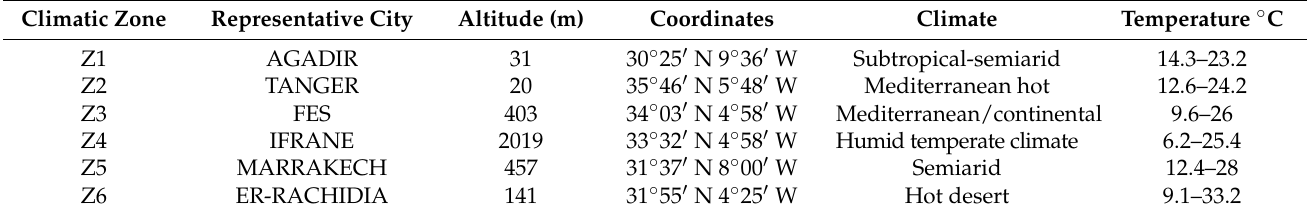
Table 3. General Information of the climatic zones under